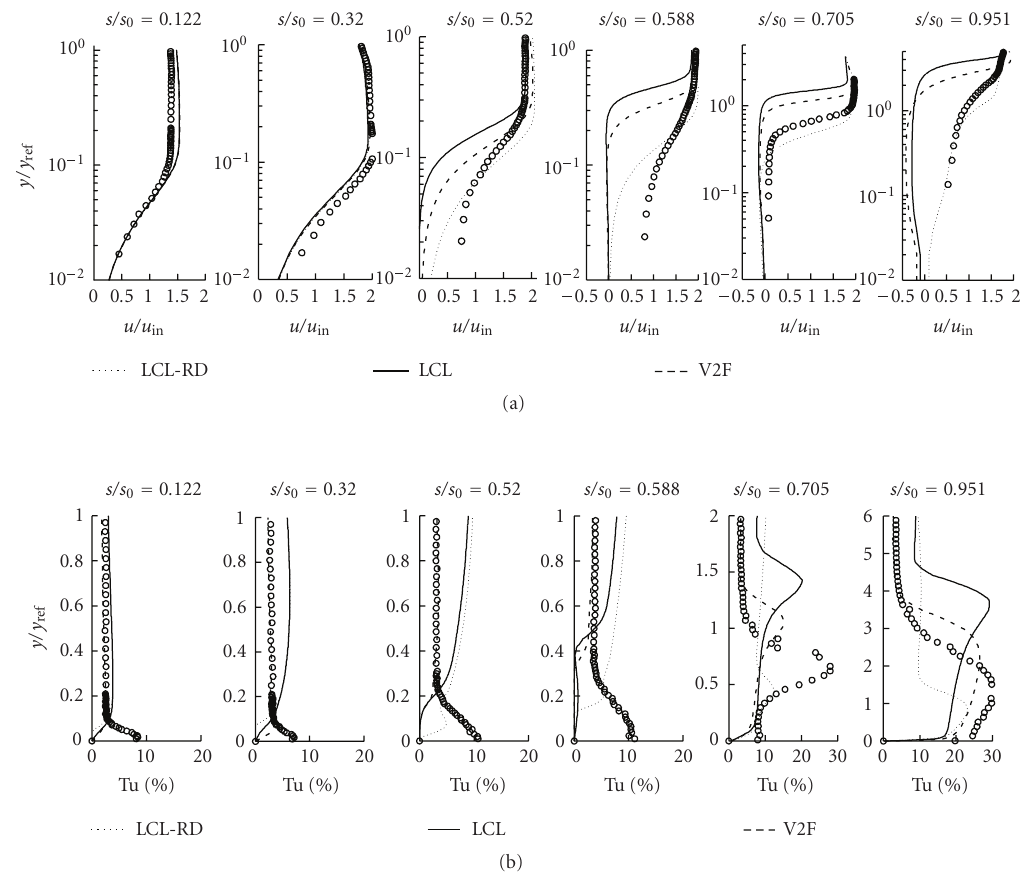
Figure 8: Velocity and turbulence profiles on the suction side for di ff erent turbulence models for the undisturbed case.